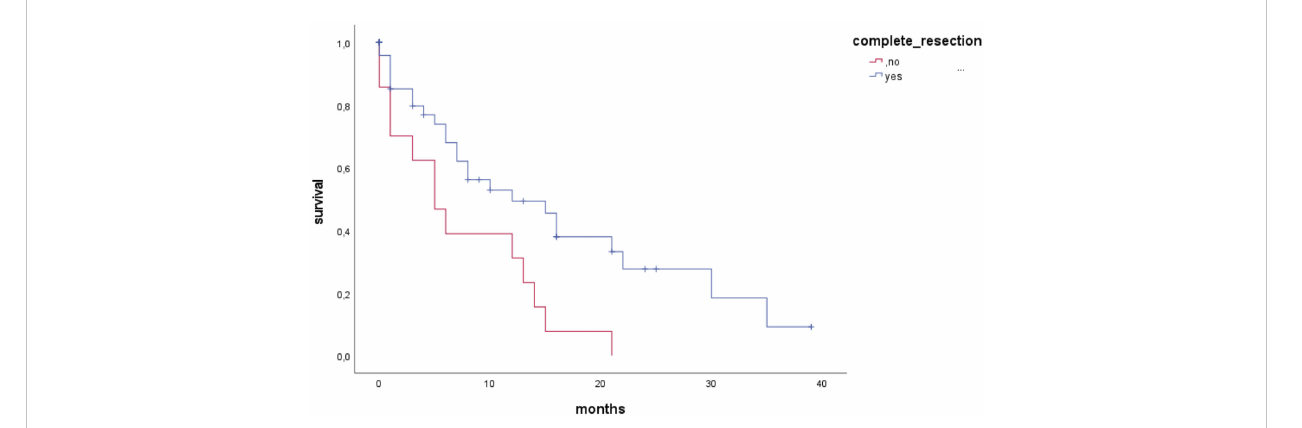
FIGURE 4 Kaplan-Meier curves for OS of elderly patients with a single brain metastasis (singular, solitary), strati fi ed for complete vs. incomplete